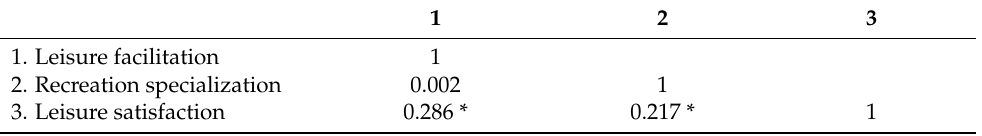
Table 4. Correlation of leisure facilitation, recreation specialization, and leisure